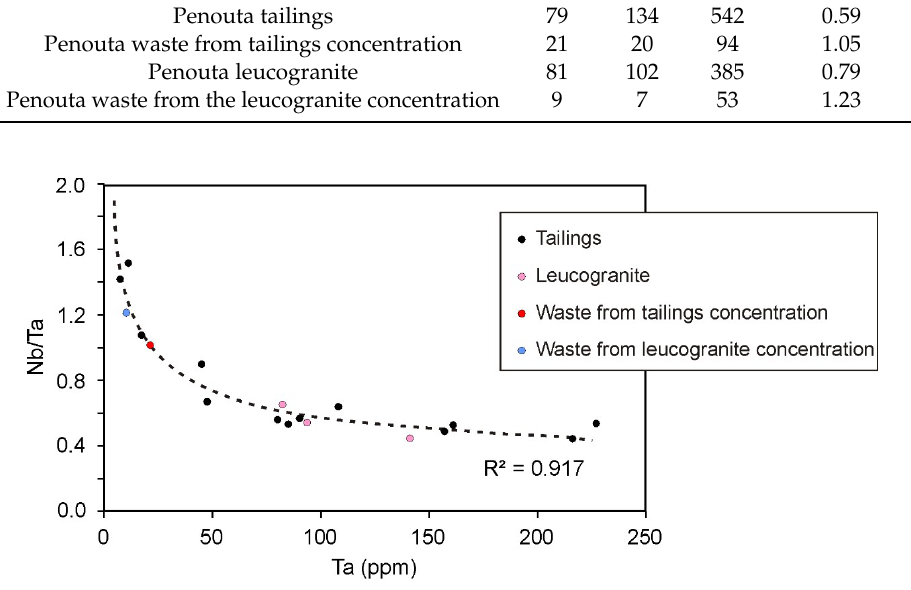
Figure 5. Nb/Ta ratio vs. the Ta content from Penouta materials. Figure 5. Nb / Ta ratio vs. the Ta content from Penouta